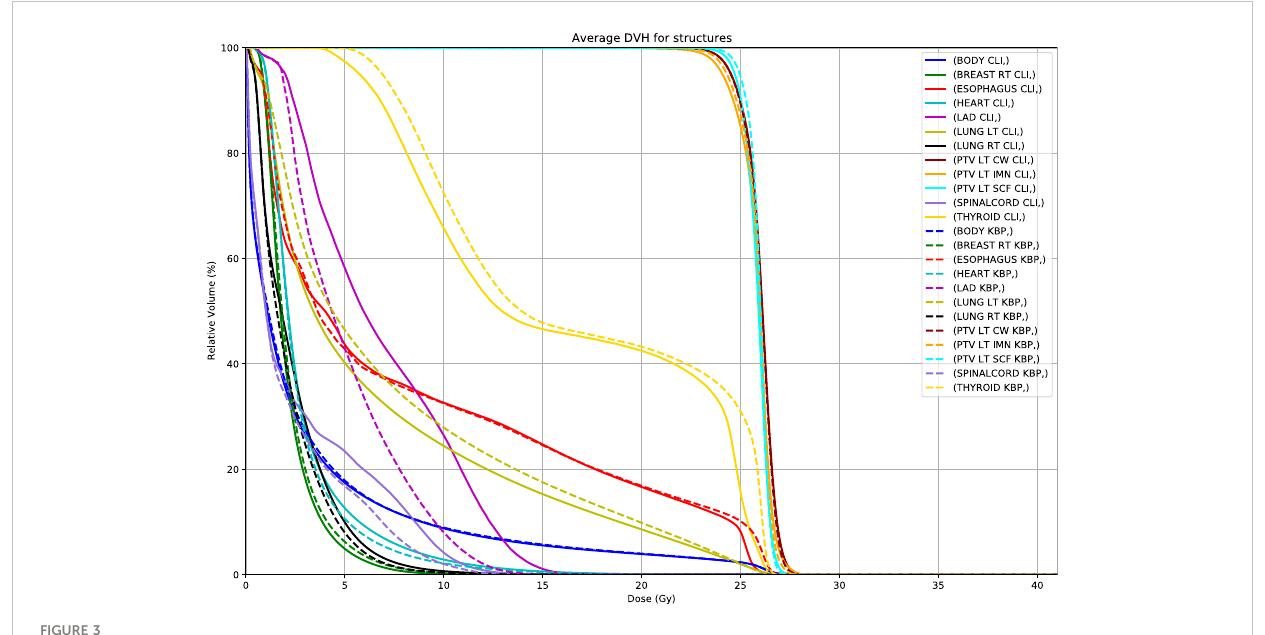
FIGURE 3 Average DVH comparison of CLI and KBP_26Gy in 5 fractions.